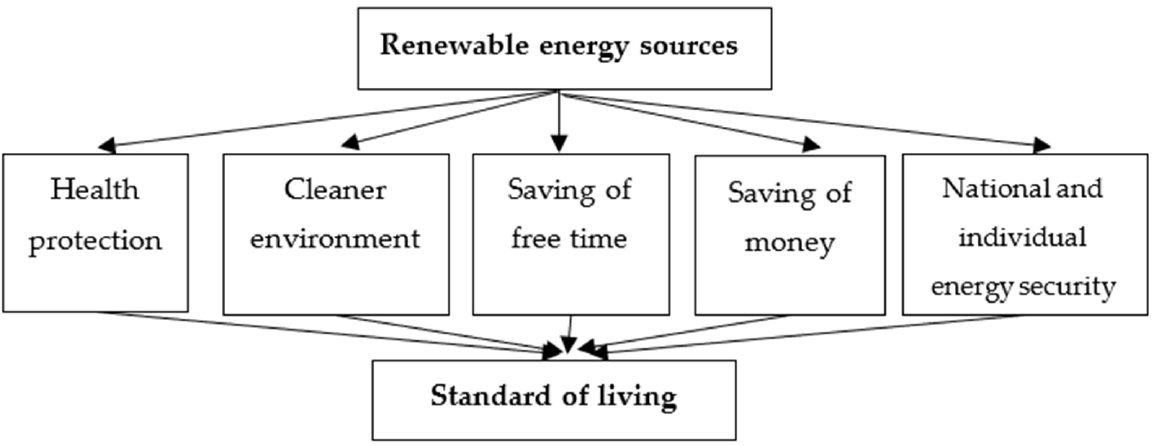
Figure 1. The impact of RES on the standard of living.